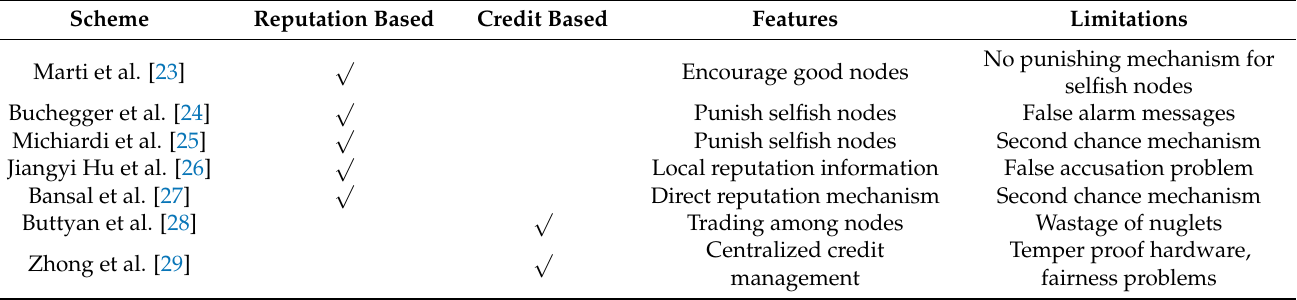
Table 1. Existing works with pros and